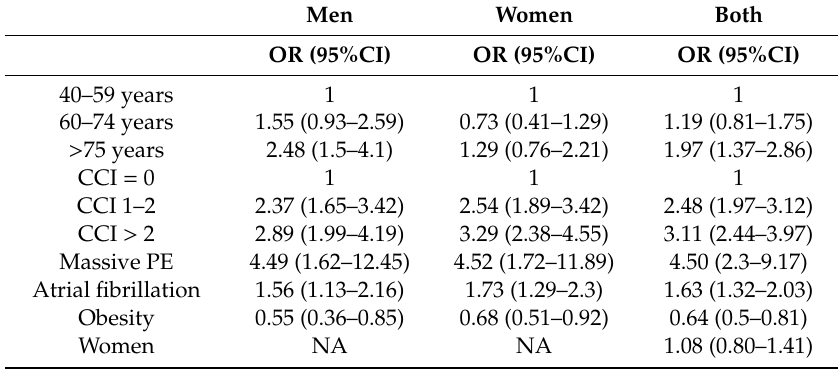
Table 4. Multivariate analysis of variables associated with in-hospital mortality among men and women with type 2 diabetes mellitus hospitalized for pulmonary embolism in Spain (2016–2018). Men Women